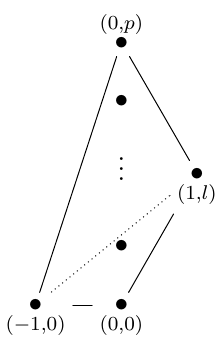
Figure 3 . One of the triangles defined in the